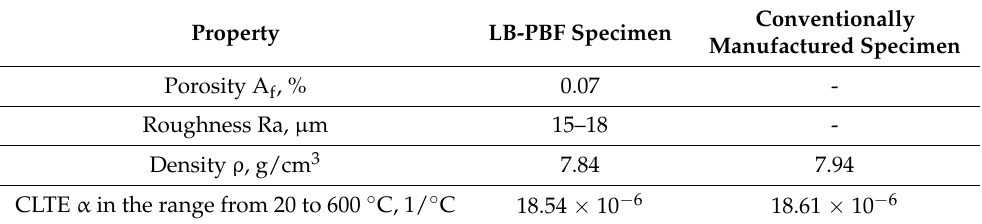
Table 4. Physical properties of specimens made by the LB-PBF and comparison with the properties of conventionally manufactured specimen of the same